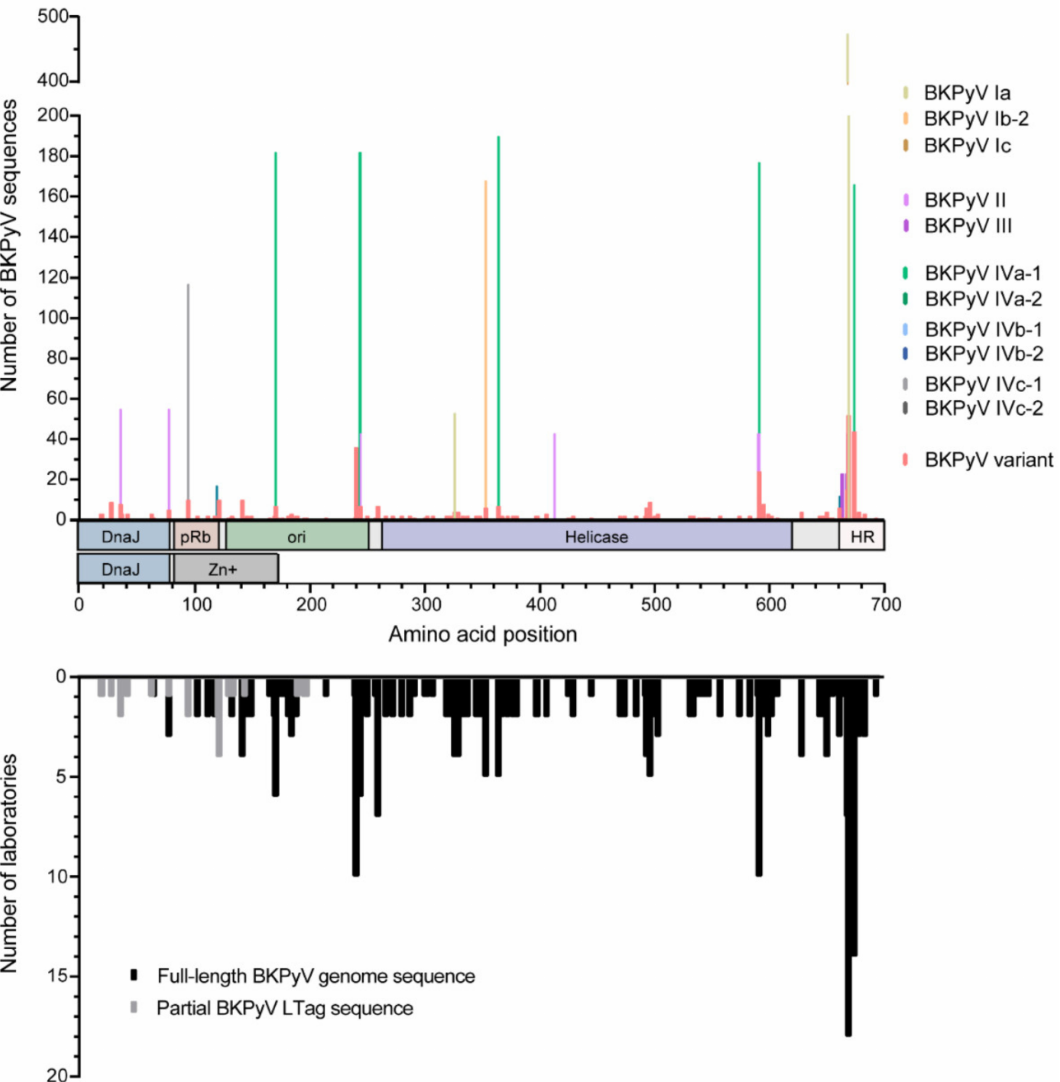
Figure 2. Variation in the BKPyV LTag protein sequence. BKPyV subtype specific variation and amino acid exchanges not related to a certain BKPyV subtype (i.e., BKPyV variants) in the large tumor antigen (LTag) protein sequence were identified (upper panel); number of laboratories that deposited full-length BKPyV genome or partial LTag sequences from BKPyV-variants (lower panel). Schematic drawing of the respective domains in LTag and small T antigen (sTag; according to DeCaprio and Garcea [44]) are indicated below the diagram (DnaJ homology region (DnaJ), retinoblastoma protein binding domain (pRb), origin of DNA replication binding domain (ori), host range domain (HR)). Of note, the amino-terminal part including the DnaJ homology domain is identical for sTag and LTag, whereas the carboxyterminal domains indicated are specific for sTag or